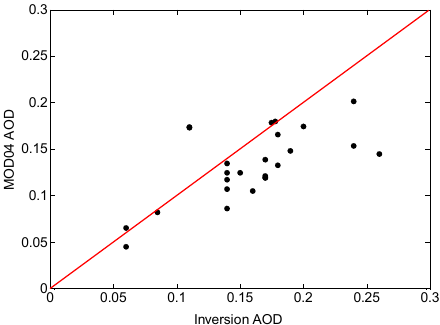
Figure 7. The AOD comparison of inversion and MOD_04. The black dots represent 25 sets of geographical location, and the red solid line represents y = x.